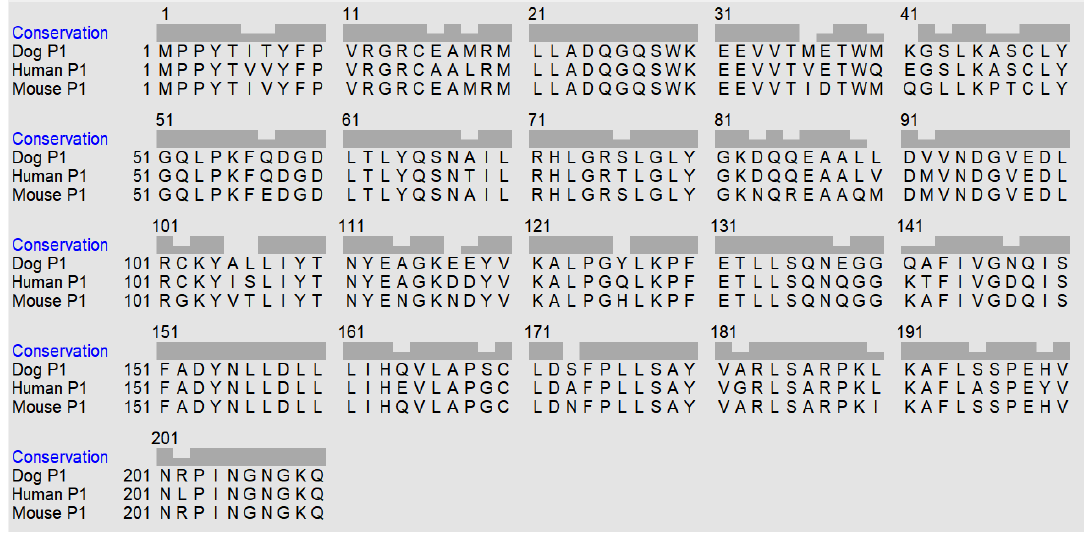
Figure 2. Alignment of dog, human, and mouse GST P1 sequences.